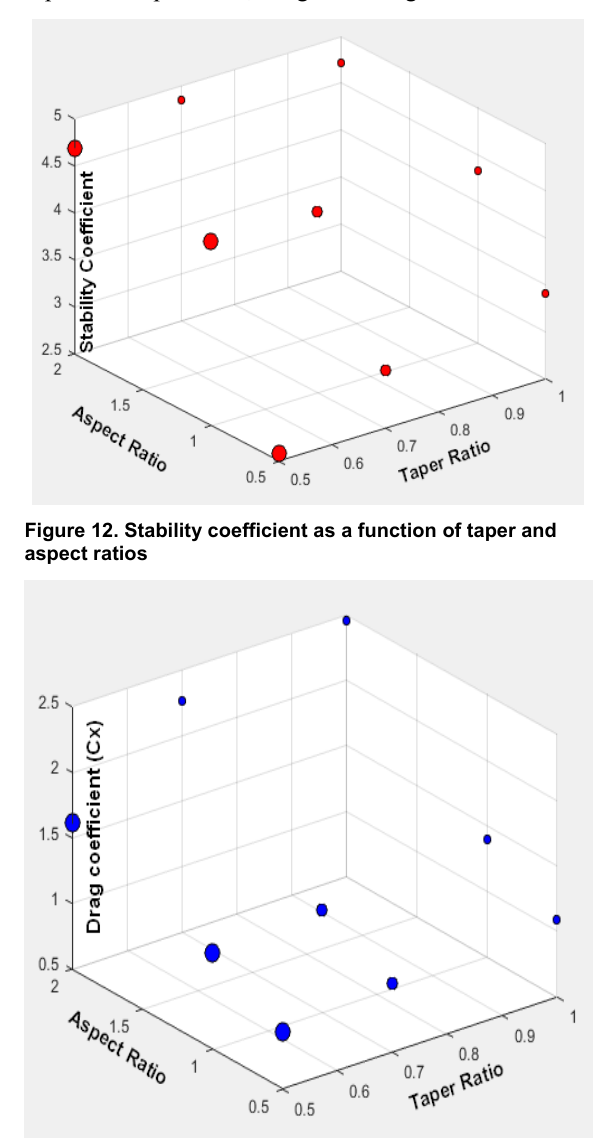
Figure 13. Drag coefficient as a function of taper and aspect